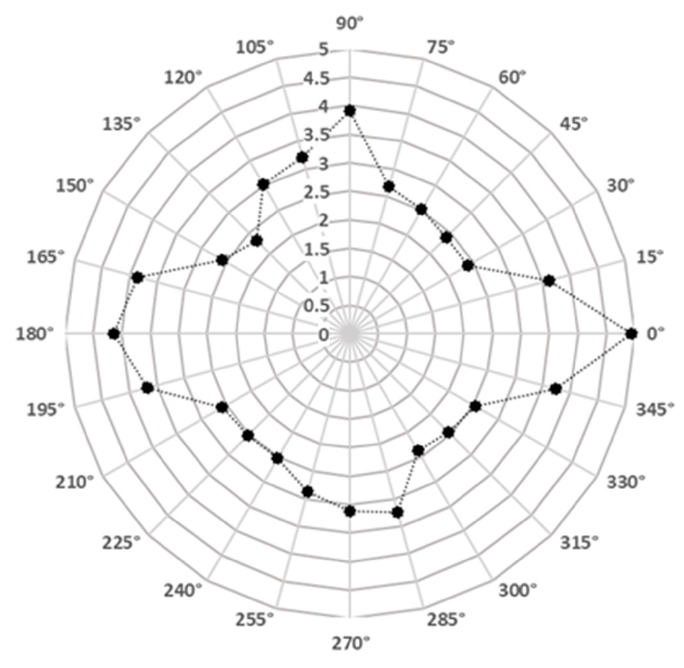
Figure 7. Relationship between tracking direction and IP.